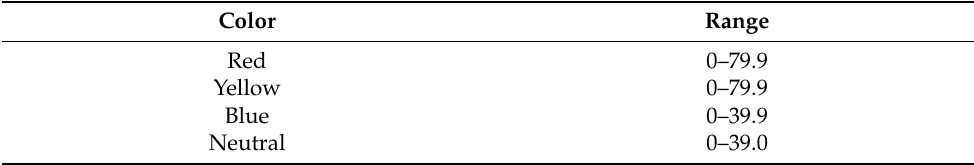
Table 1. Lovibond RYBN color